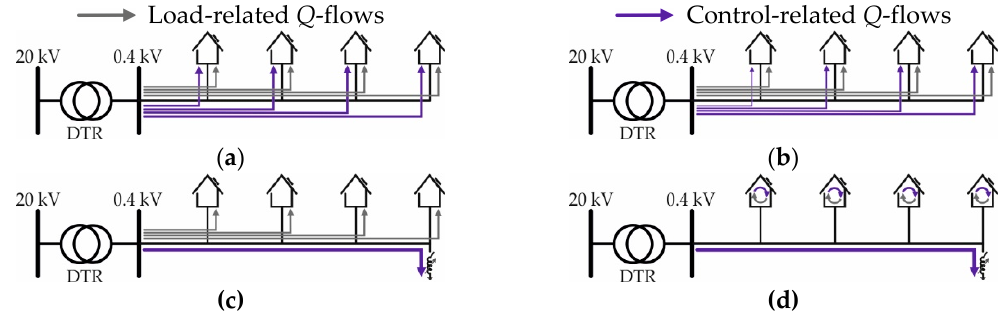
Figure 4. Load- and control-related reactive power flows provoked by the different control strategies: